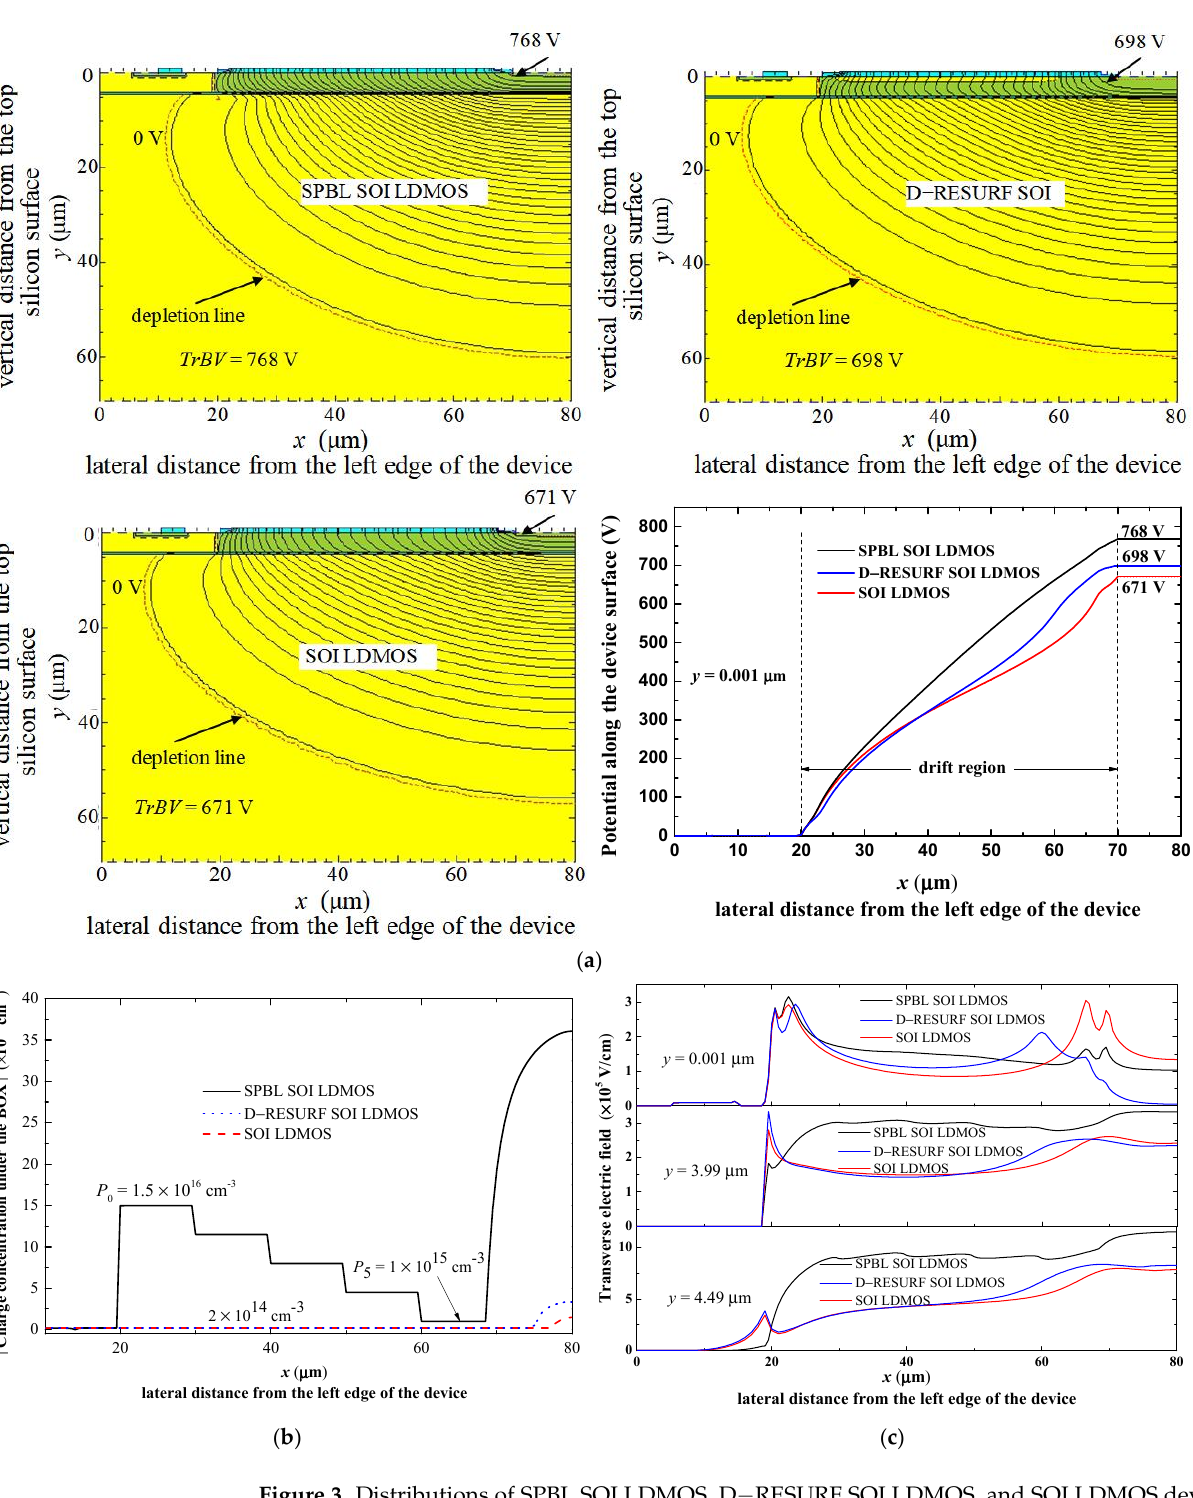
Figure 3. Distributions of SPBL SOI LDMOS, D − RESURF SOI LDMOS, and SOI LDMOS devices’ ( a ) potential (20 V/contour), ( b ) charge under the BOX, and ( c ) lateral electric fi eld.